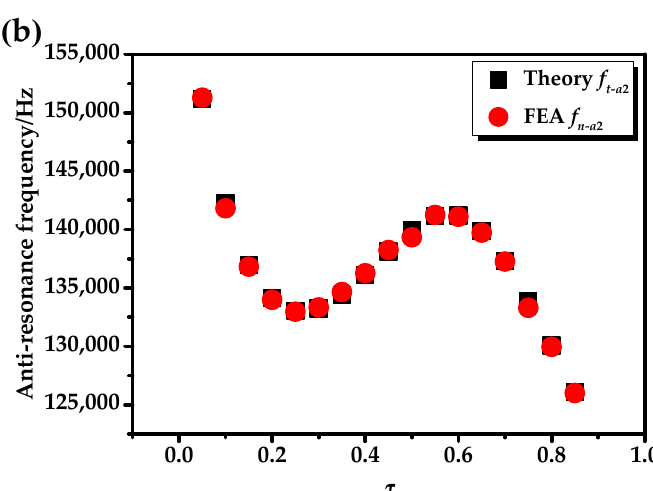
Figure 6. The relationships between the radial resonance, anti-resonance frequency, and τ at the second mode: ( a ) resonance frequency ( f r 2 ); ( b ) anti-resonance frequency ( f a 2 ).